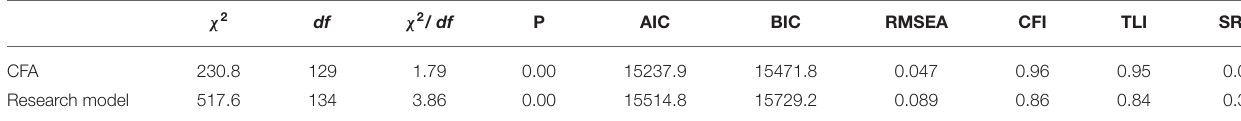
TABLE 5 | Fit indices for the estimated model.